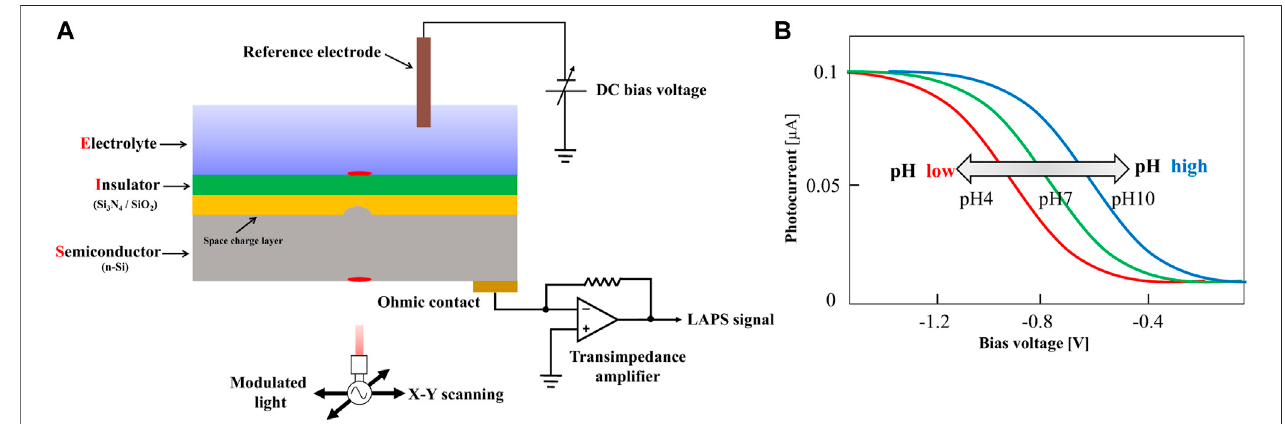
FIGURE 2 | (A) Schematic representation of a typical LAPS set-up; (B) I-V characteristic curve of the LAPS(Yoshinobu et al.,